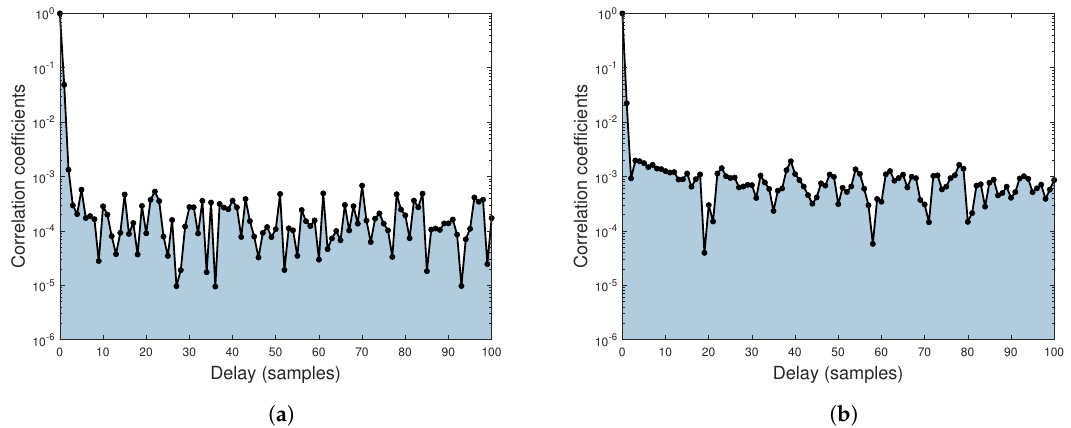
Figure 6. Correlation coefficients for ( a ) electronic noise samples and ( b ) noise samples taken at a LO power of 12 dBm. At the chosen sampling rate, the delay between two consecutive samples is approximately